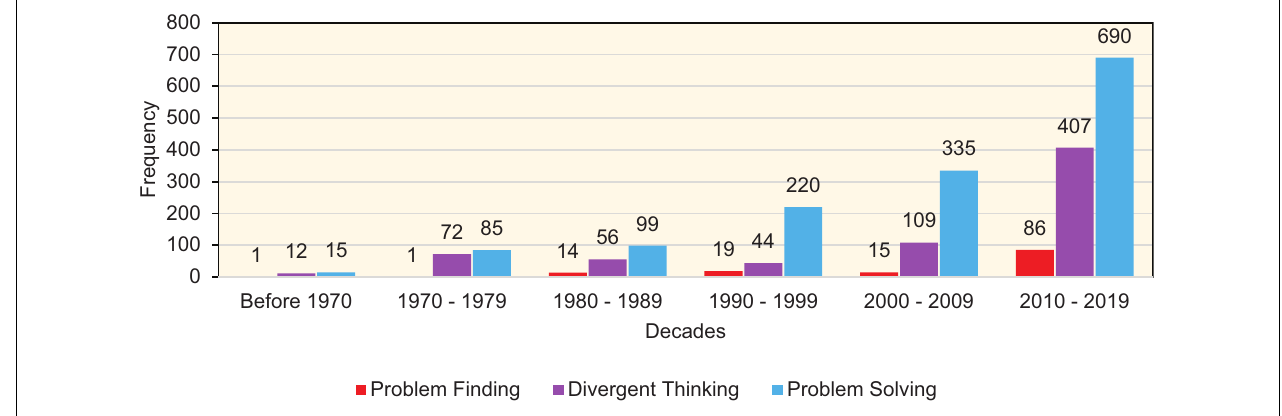
FIGURE 1 | Number of publications focusing on problem finding, DT, and problem solving in the past five decades.